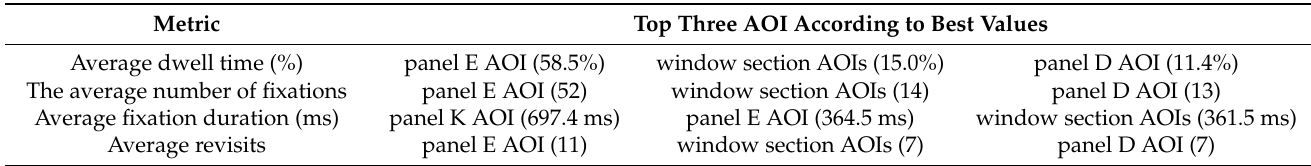
Table 9. The departure procedure’s average statistic for railway stop